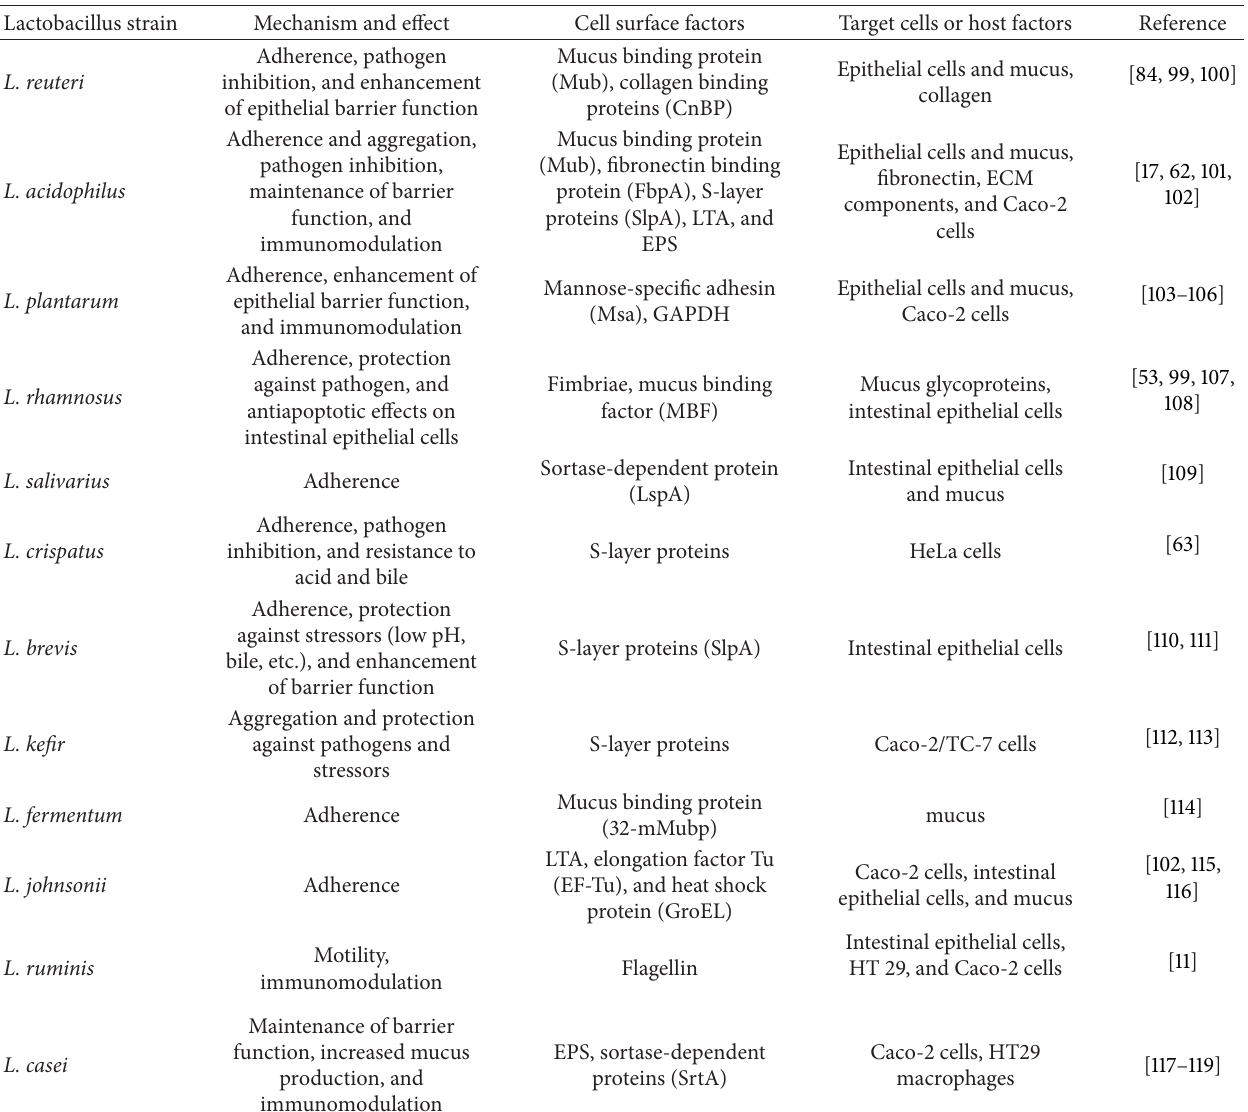
Table 1: Lactobacilli cell surface factors implicated in microbe-host